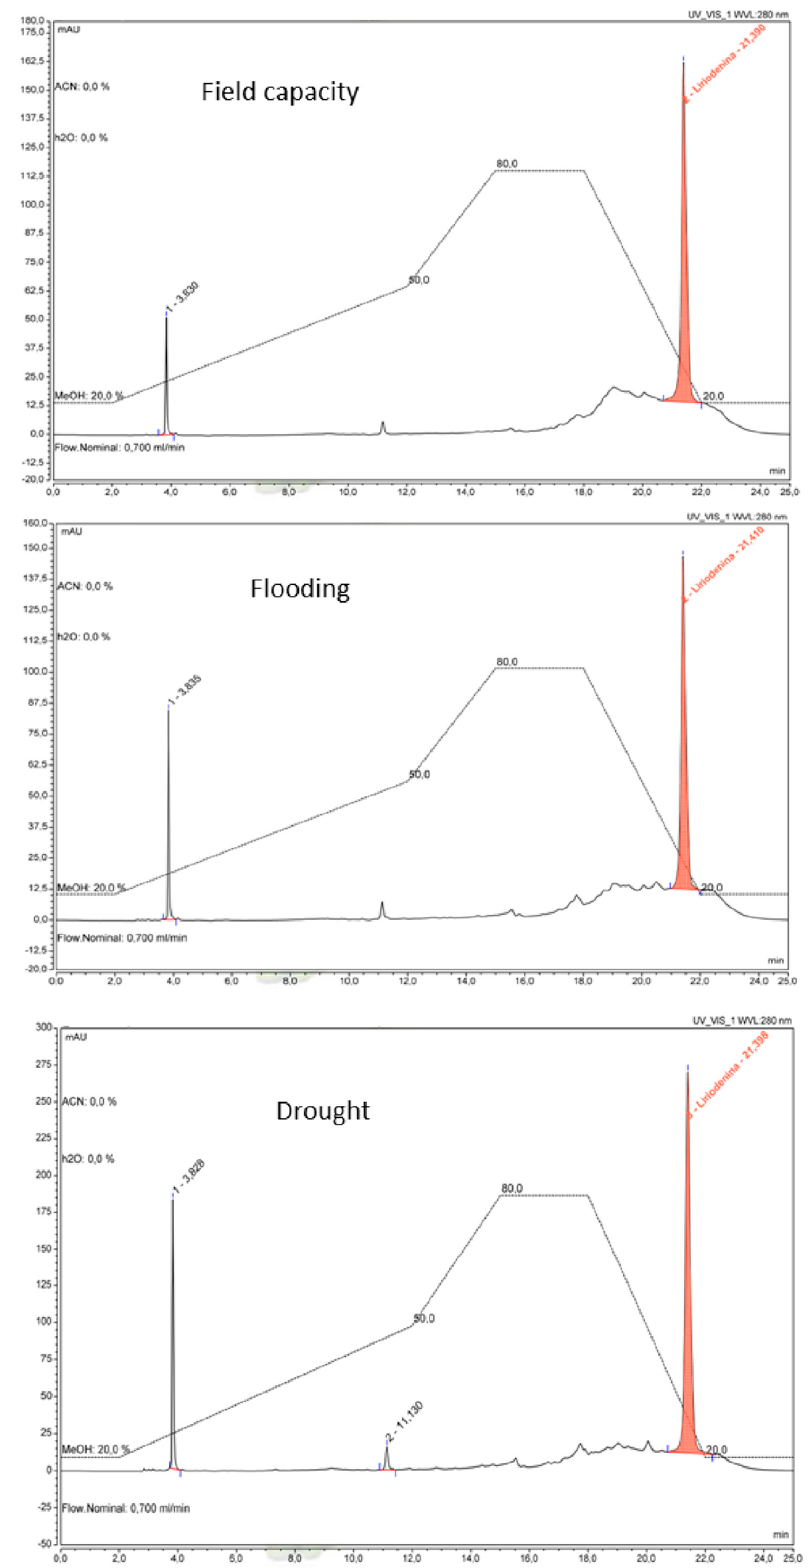
Figure 3. Chromatogram indicating liriodenine obtained from young A. crassiflora plants submitted to three water condition levels [Field Capacity ( − 0.01 MPa); Flooding and Drought ( − 1.5 MPa)] at 18 days after the beginning of